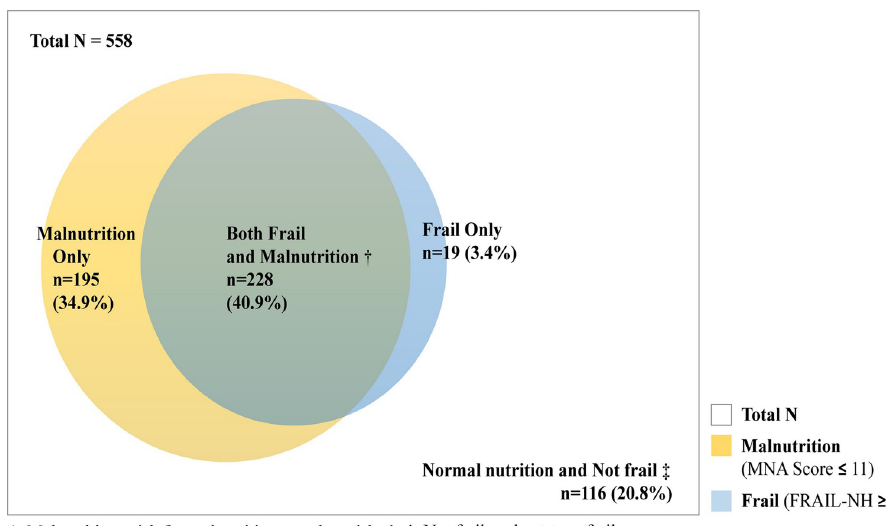
Fig 2. Venn diagram showing the co-existence of frailty and